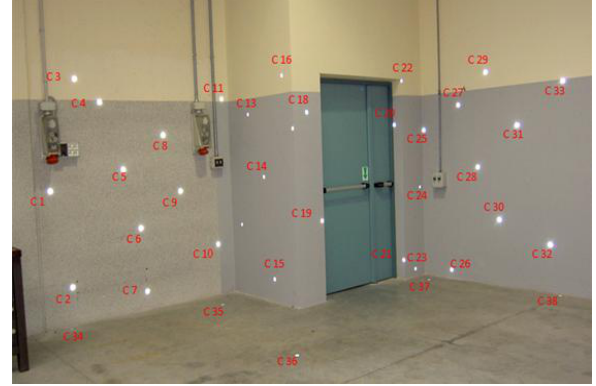
Figure 1. The calibration test-field